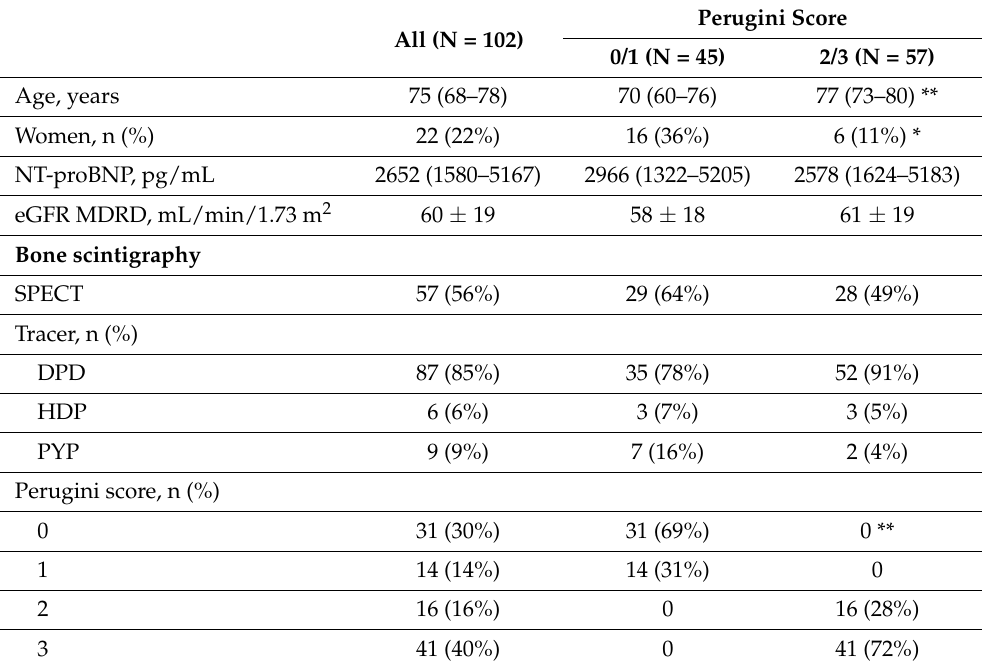
Table 1. Baseline characteristics of the total sample and stratified by Perugini